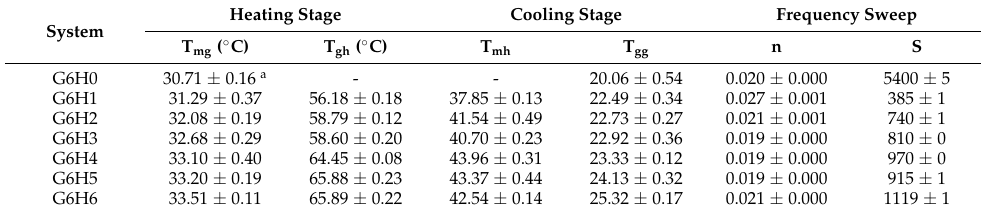
Table 1. Melting temperatures, gelling temperatures, n, and S of GA and GA/HPMC blends. Heating System